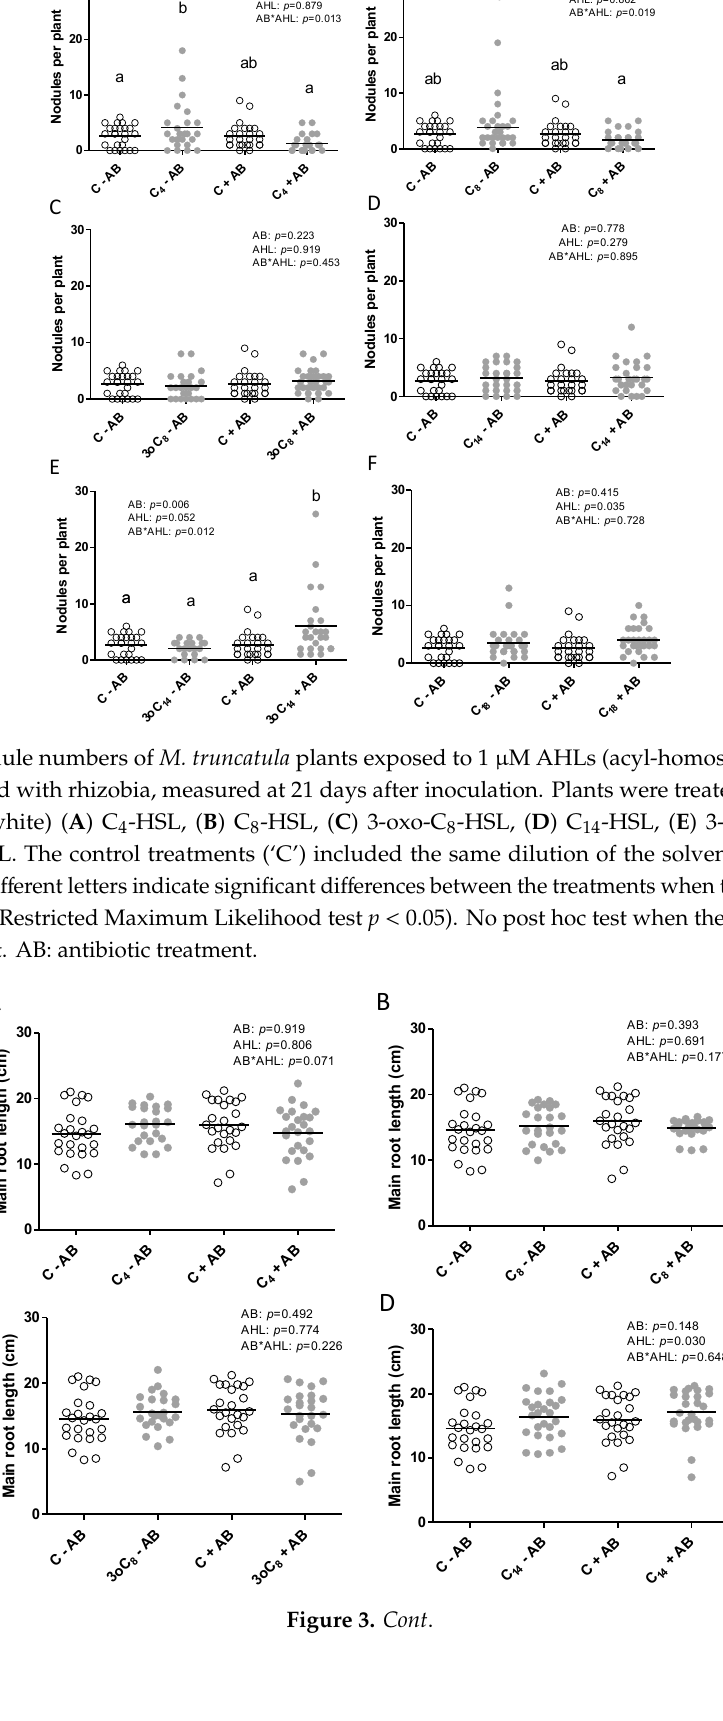
Figure 3. Root length of M. truncatula plants exposed to 1 μ M AHLs and inoculated with rhizobia, measured at 21 days after inoculation. Plants were treated with (grey) or without (white) ( A ) C 4 -HSL, ( B ) C 8 -HSL, ( C ) 3-oxo-C 8 -HSL, ( D ) C 14 -HSL, ( E ) 3-oxo-C 14 -HSL, or ( F ) C 18 -HSL. The control treatments (‘C’) included the same dilution of the solvent as the AHL treatments. Different letters indicate significant differences between the treatments when the interaction is significant (REML test p < 0.05). No post hoc test when the interaction is not significant. AB: antibiotic treatment. Lateral root density was not affected by any of the AHLs, with a minor effect of the AB treatment in the C 18 -HSL-treated plants (Figure 4).